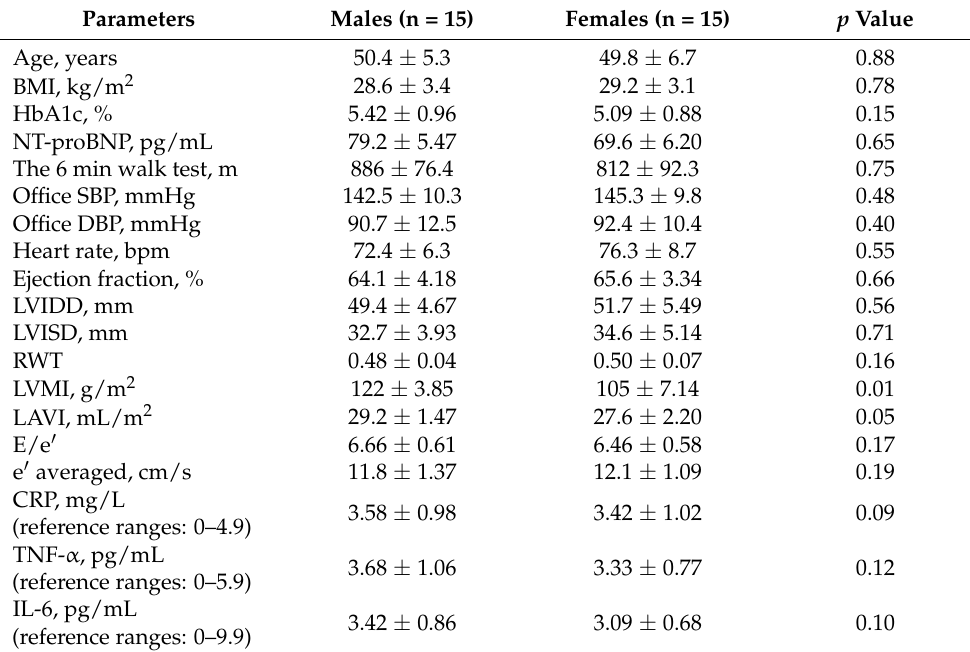
Table 2. The baseline characteristics of the examined hypertensive patients without CHF and LVDD (M ± std.